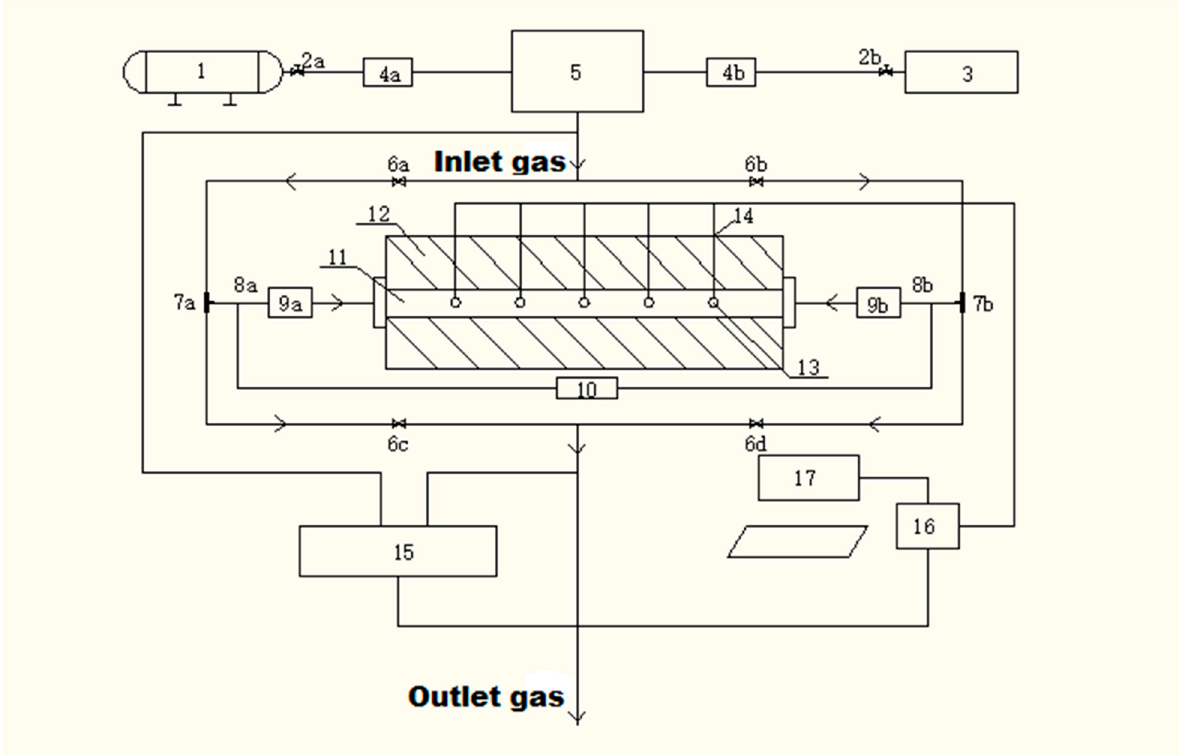
Figure 1. Apparatus flow chart of methane oxidation experiment. (1) Air compressor; (2a, 2b) pressure-reducing valve; (3) methane cylinder; (4a) rotameter; (4b) mass flow meter; (5) mixing tank; (6a, 6b, 6c, 6d) solenoid valve; (7a, 7b) three-way valve; (8a, 8b) differential pressure interface; (9a, 9b) heat exchange tube; (10) differential pressure gauge; (11) regenerator; (12) heating furnace; (13) temperature measurement point; (14) thermocouple; (15) methane gas analyzer; (16) acquisition card; (17) computer.